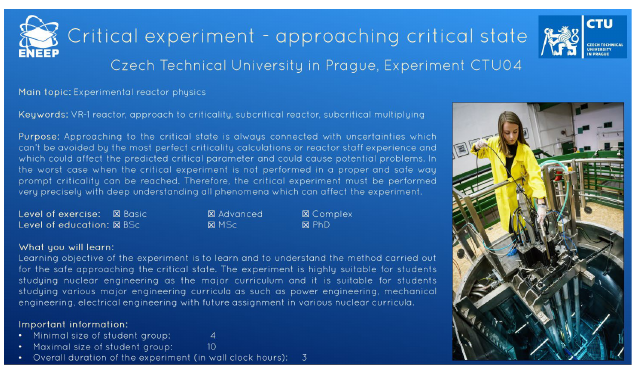
Fig. 7. Example of experiment presentation materials – CTU, Critical experiment.